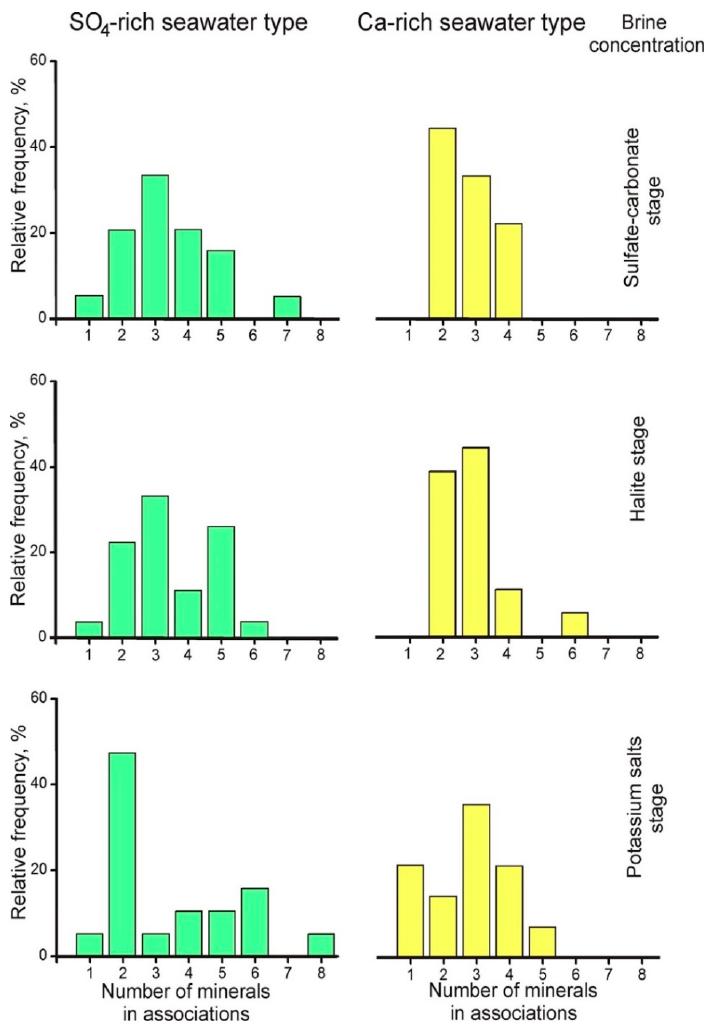
Figure 2. Quantitative distribution of clay mineral association of Phanerozoic evaporite formations deposited from seawater of SO 4 -rich and Ca-rich chemical types.